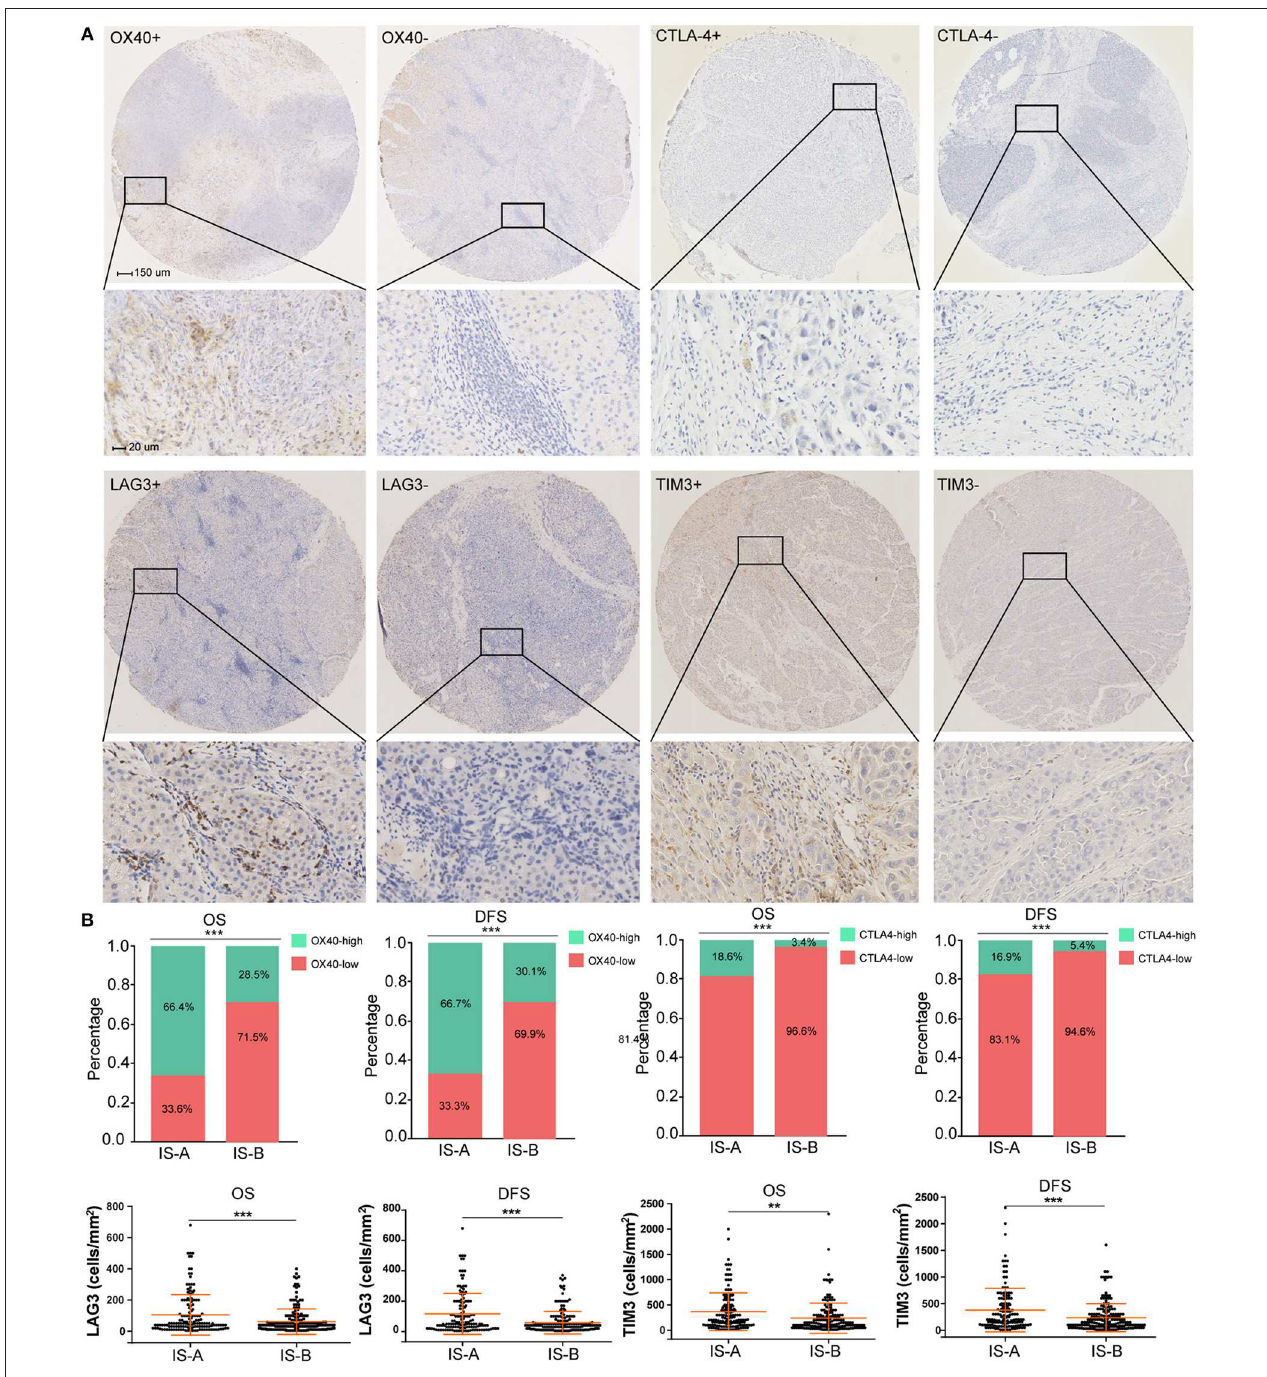
FIGURE 5 | Higher expression of multiple immunomarkers in IS-A group. (A) Representative immunohistochemistry images (positive markers and negative control) of OX40, CTLA-4, LAG3, and TIM-3 in HCC. The bars (150 and 20 µ m) are shown in the upper left figures. (B) Associations of immune type with the immune check-point markers. According to the data distributions, the optimal cut-off values for OX40 and CTLA-4 were selected to perform comparisons between groups. TIM-3 and LAG3 expressions between two immune types were compared by continuous data. ** P < 0.01; *** P < 0.001.